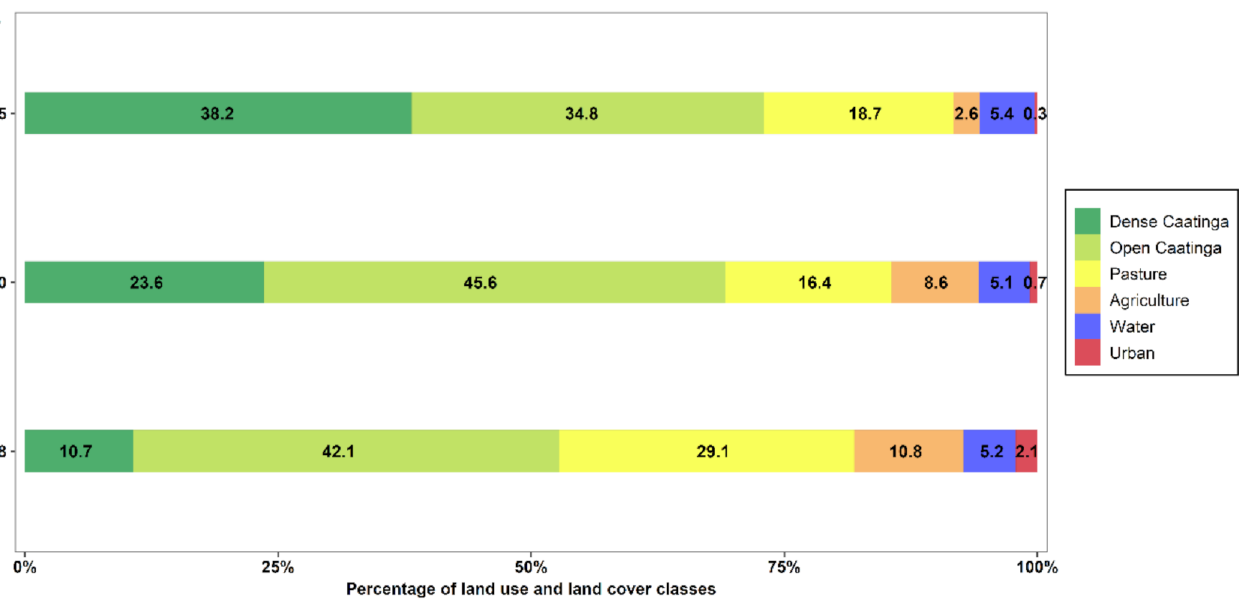
Figure 3. Comparison of the respective extents of land use/land cover classes by percentage of study area (study area = 846,400 ha).